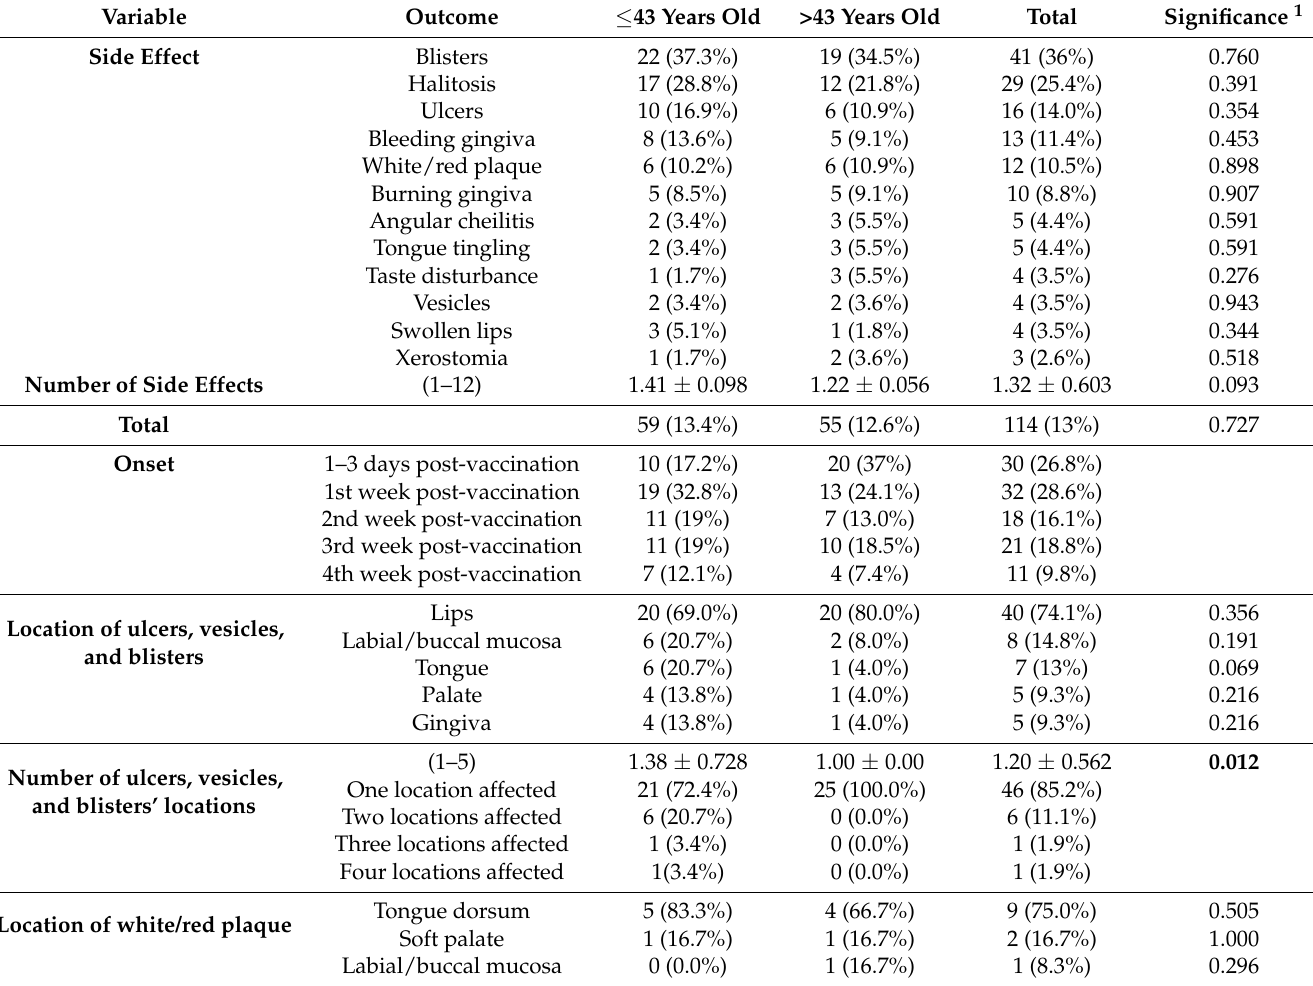
Table 7. Prevalence of oral side effects of Pfizer–BioNTech COVID-19 vaccine among healthcare workers in the Czech Republic, January–February